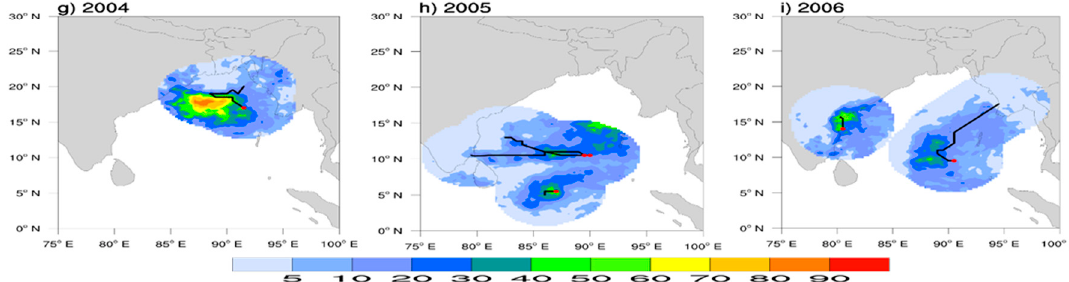
Figure 6. Yearly TC rainfall contribution (%) from 1998 to 2006. ( a ) 1998, ( b ) 1999, ( c ) 2000, ( d ) 2001,